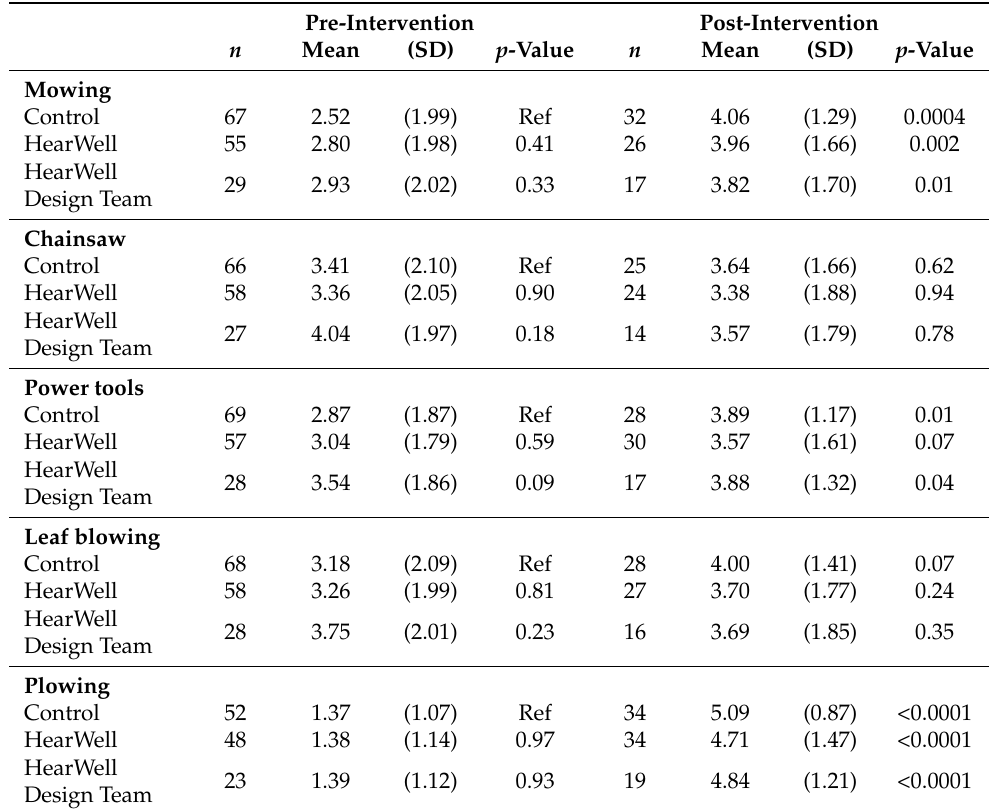
Table 6. Self-reported at-home hearing protection device use frequency (1 rarely/never to 6 always) by task and intervention arm. p -values represent the statistical significance as compared to the control at pre-intervention using a mixed linear